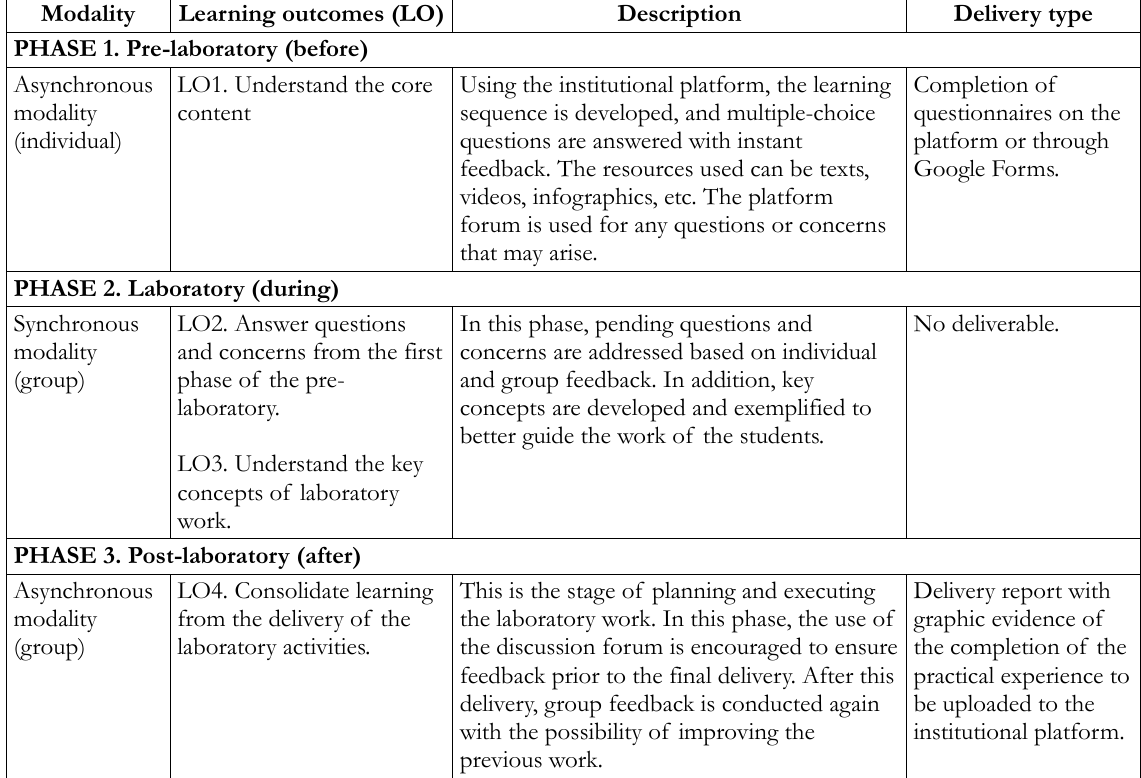
Table 2. Description of the three phases of teaching innovation conducted in the theoretical-experimental subject General Chemistry during 2020